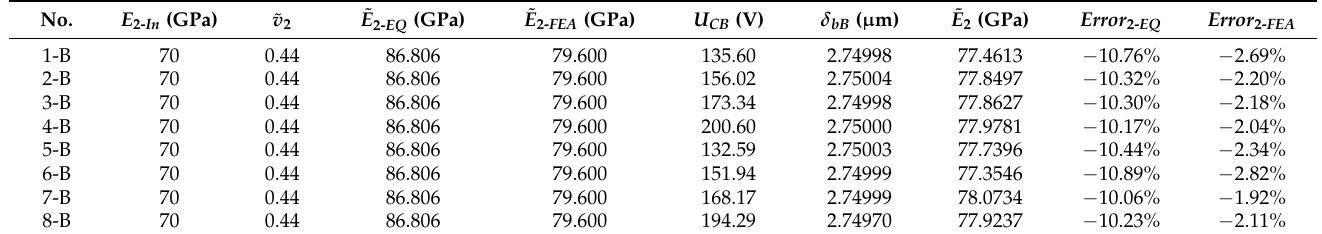
Table 4. Finite element simulation results of test structure B.